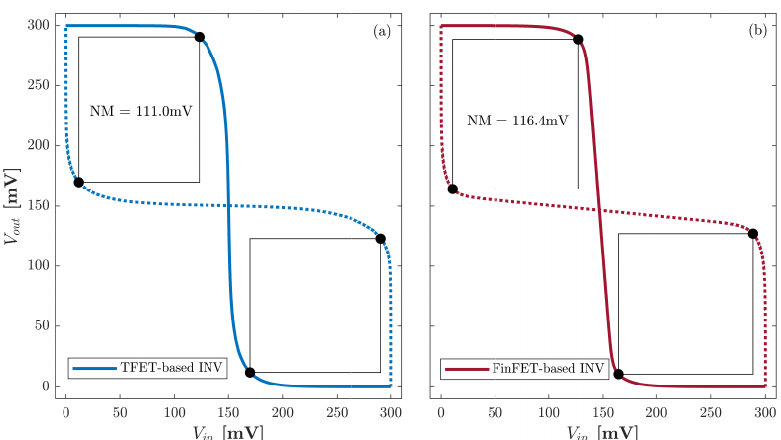
Figure 3. Butterfly plot at V DD = 300 mV for a ( a ) TFET-based and ( b ) FinFET-based inverter with W P / W N ratios of 3/1 and 1/1, respectively, showcasing the effect of the sizing methodology on the noise